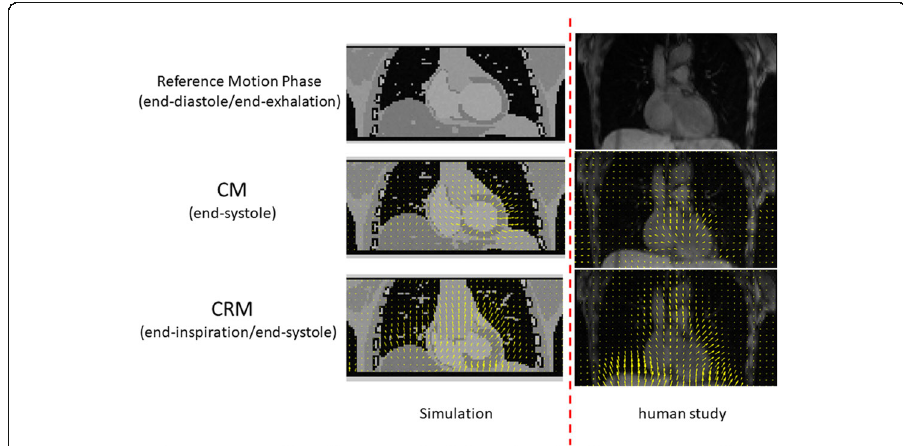
Fig. 4 Coronal MR images for two different motion phases along with the estimated motion fields between the two motion phases